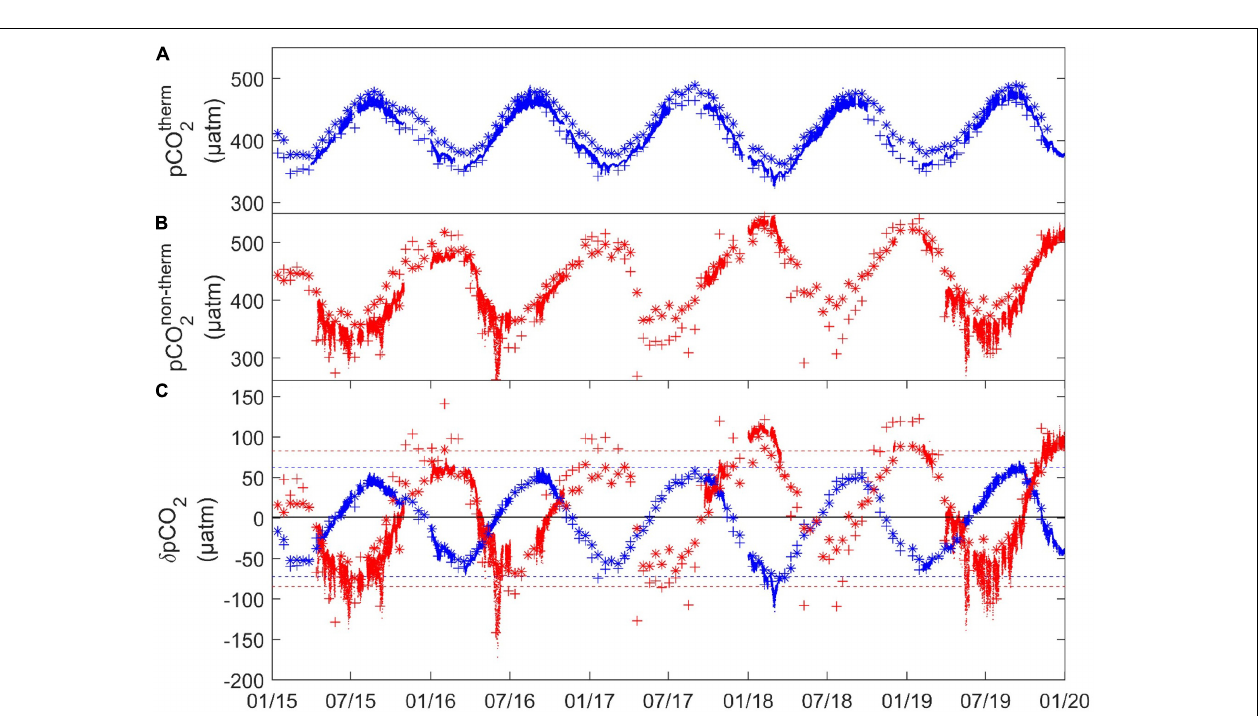
FIGURE 8 | (A) pH calc (in pH units on the total scale at in situ SST) at the ASTAN buoy during the year 2016 as explained in Section “Carbonate System Parameters” with (B) emphasis on the spring short-term variability of pH calc (black dot) and the water level [in meters (orange line)] from 28/05/2016 to 09/06/2016.